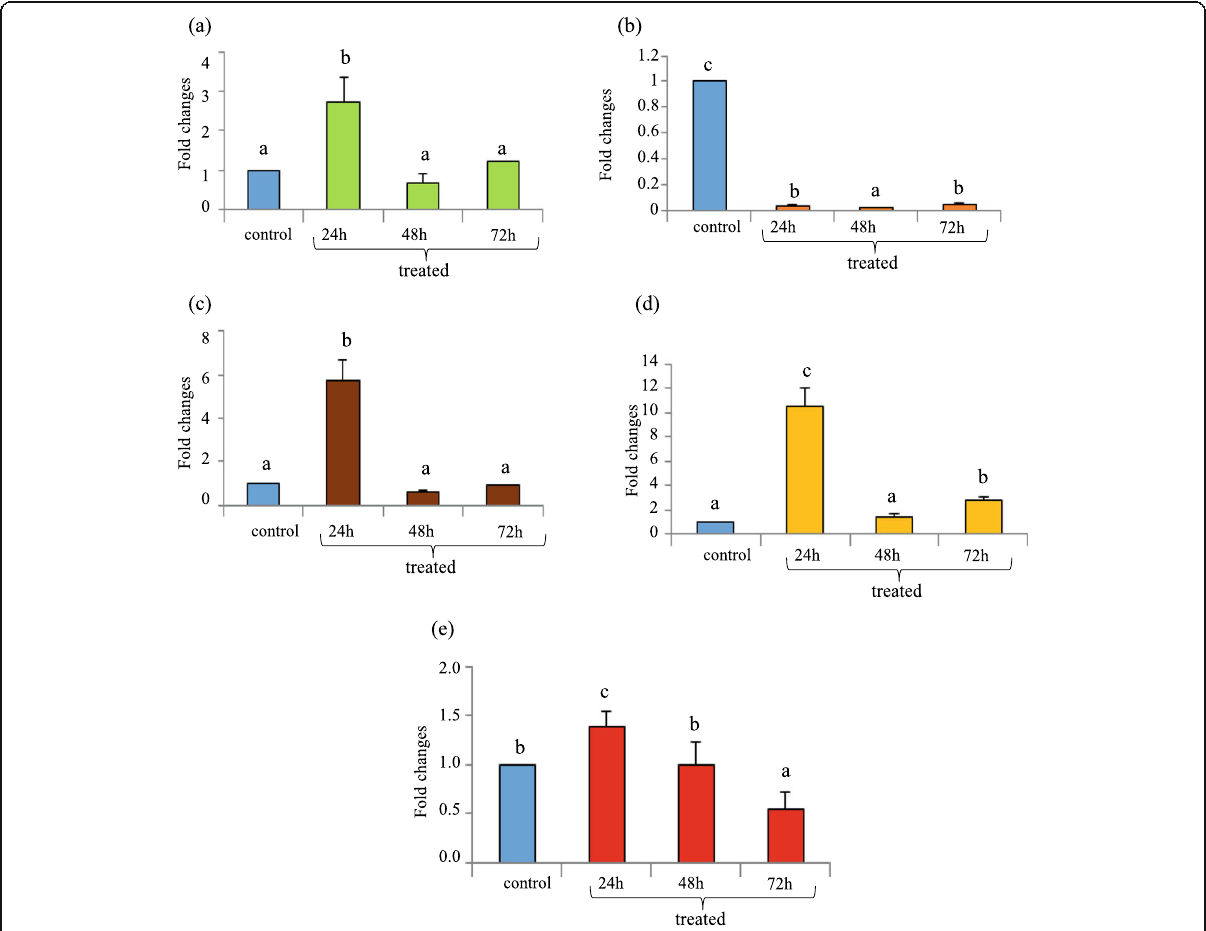
Fig. 7 Modulation of caspase-8 gene in Labeo rohita in response to E. tarda infection. Labeo rohita fingerlings ( n = 3) were intra-peritoneally (i.p.) infected with E. tarda (3 × 10 6 CFU/fish), for 24, 48, and 72 h. Then, the gill, kidney, liver, spleen, and blood were collected from the un-infected control and E. tarda infected fish and total RNA was extracted. Following cDNA synthesis, caspase-8 and β -actin gene expression in each sample was analyzed by the qRT-PCR assay. Caspase-8 gene expression in each tissue has been normalized to the β -actin gene (housekeeping), and relative expression of caspase-8 gene (mean ± standard errors (bars)) has been represented as fold changes compared to the un-treated control fish ( n = 3). a Gill. b Liver. c Kidney. d Spleen. e